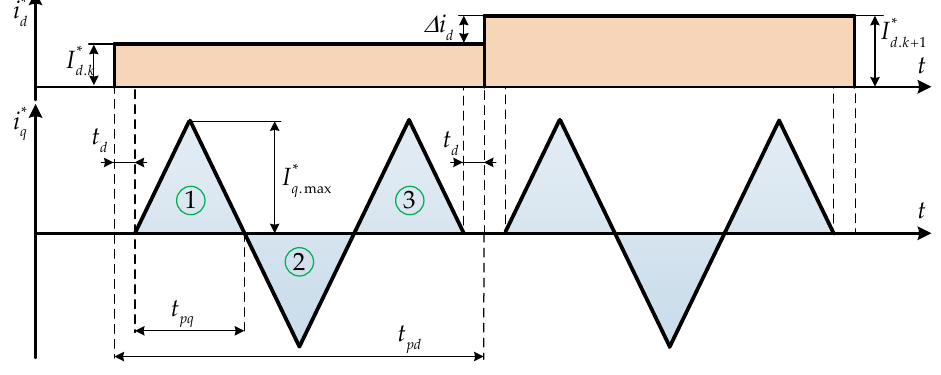
Figure 1. Proposed identification test